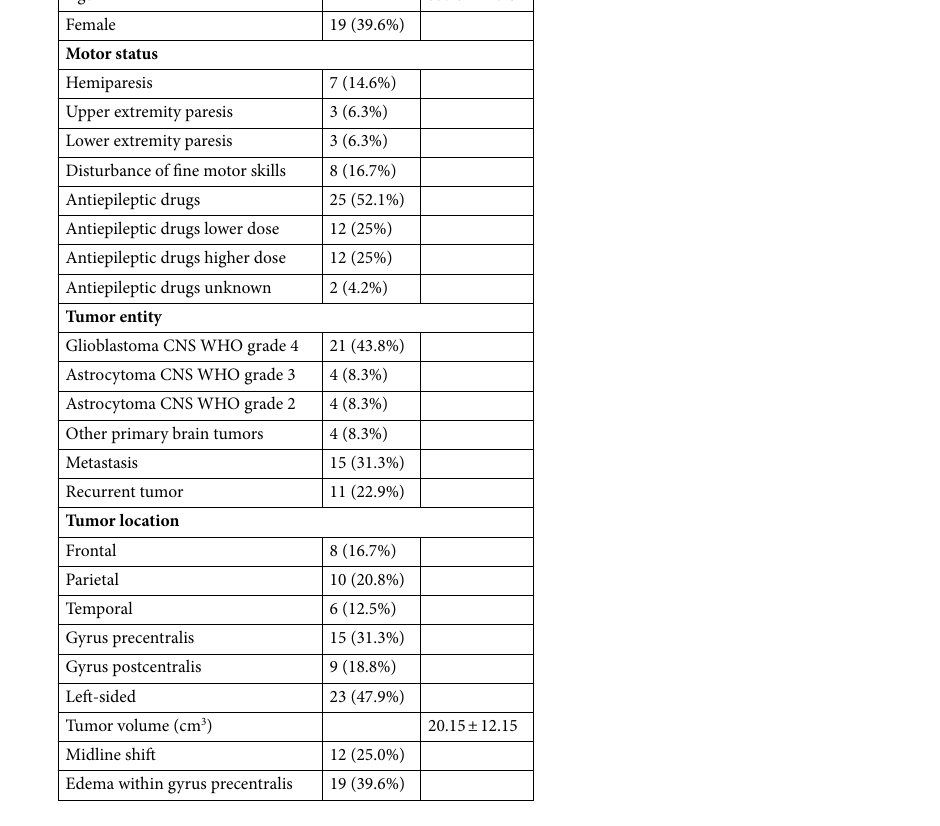
Table 1. Overview of the whole patient